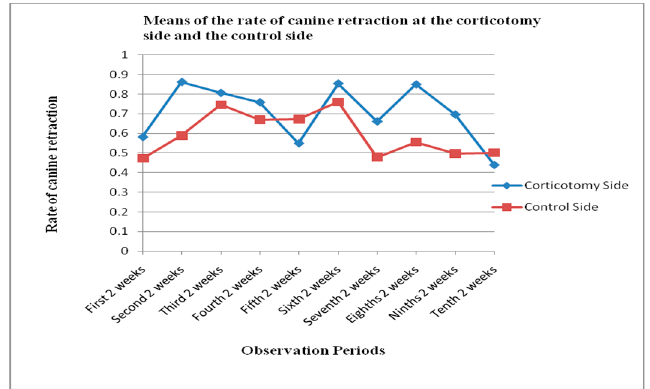
Figure 2. Rate of canine retraction at the partial corticotomy side and the control side during the observation periods of the study (every two weeks) as measured clinically (mm/week).